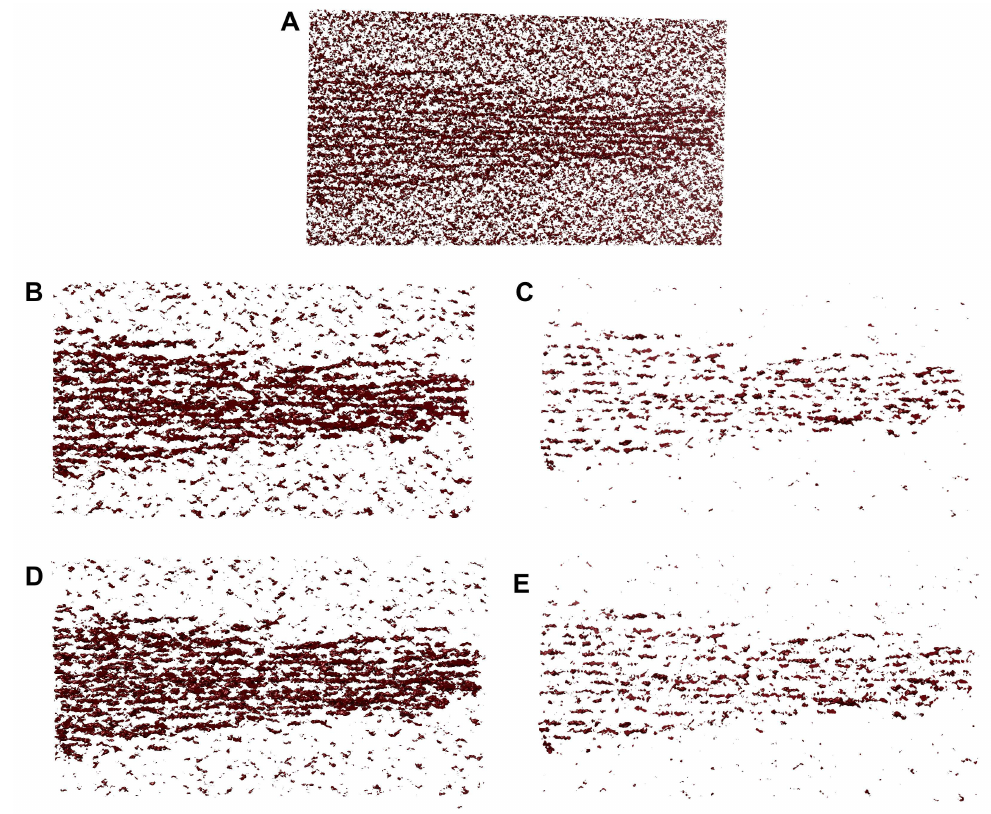
Figure 5. Comparison of the unfiltered and various CPD -filtered maps using l = 5 voxels. The same 10-voxel-wide slab of Figure 3C) is shown, except that it is rendered at the mean + standard deviation isolevel to emphasize the noise. ( A ) Original unfiltered map with a noise level of 0.8 (as in Figure 3C). ( B ) The map filtered by multiplication of FPD and BPD (Equation (5)). ( C ) The map filtered by addition/arithmetic mean (Equation (6)). ( D ) The map filtered by the geometric mean (Equation (7)). ( E ) The map filtered by the minimum (Equation